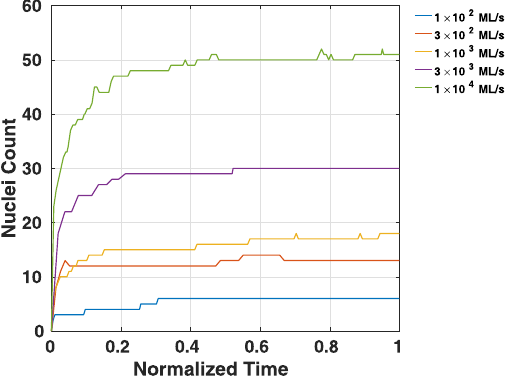
Figure 6. Homogeneous nuclei count as a function of normalized time under different adsorption rate at 773 K with the C/M ratio equal to 2.0. The nuclei count is within a substrate with the simulated area of 0.11 μ m 2 .